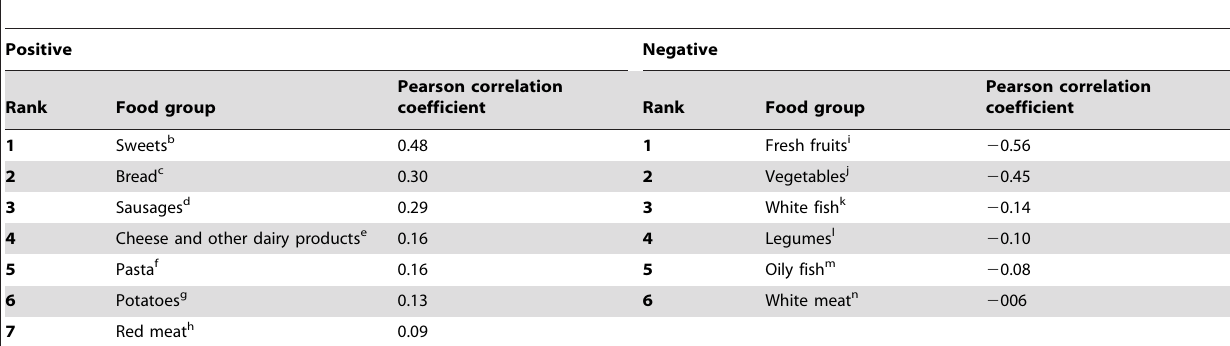
Table 5. Top positive and negative Pearson correlations coefficients between food groups and total energy density from solid food a